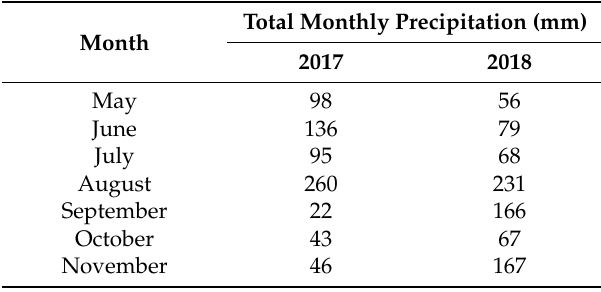
Figure 9. Grain sorghum heights as affected by each herbicide drift treatment averaged over application timing at 14 DAA in 2018. Same letters on bars indicate no significant differences at p < 0.05, according to Fisher’s least significant difference test. Table 2. Total monthly rainfall received at the study location in 2017 and 2018.